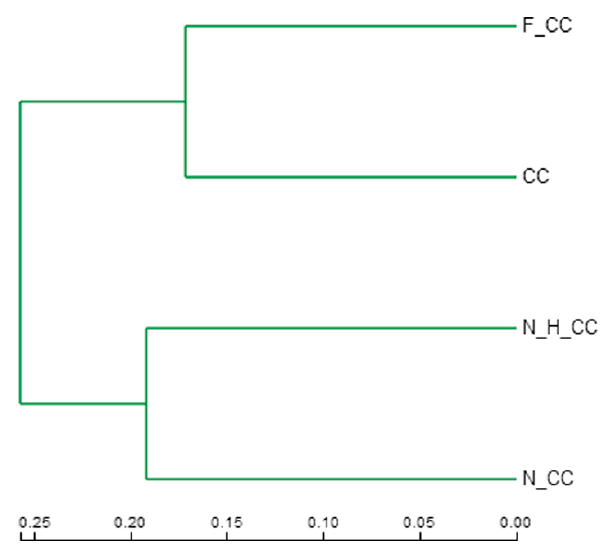
Figure 8. Hierarchical clustering tree on genus level for CC, N_CC, N_H_CC, and F_CC.